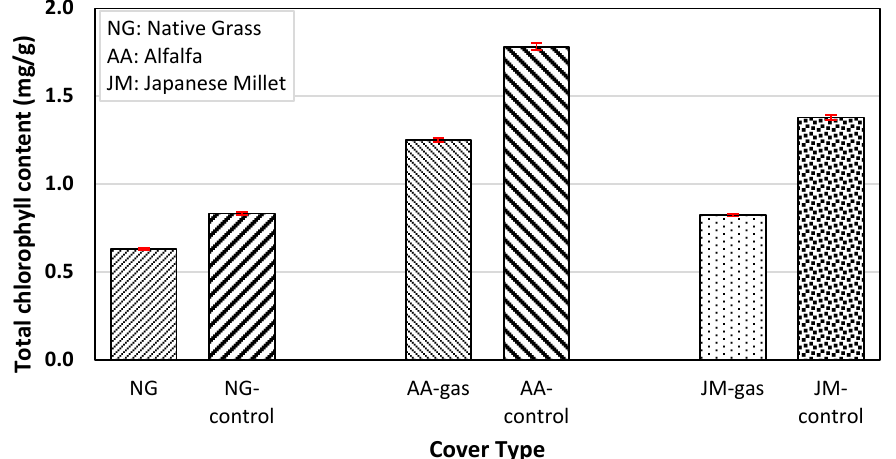
Figure 4. Chlorophyll content of different types of vegetation under two conditions: unexposed and exposed to natural gas (NG: native grass, AA: alfalfa and JM: Japanese millet).